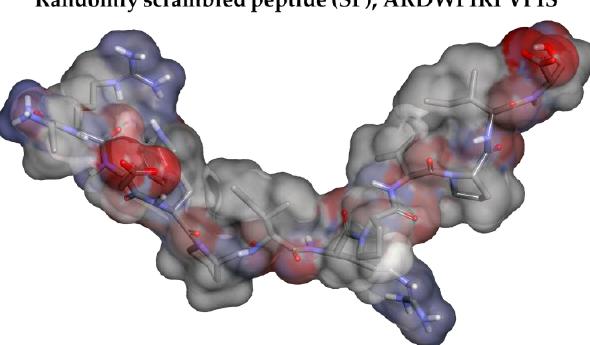
Figure 1. ( A ) Fluorescence microscopy imaging of FITC-positive cells. Primary HACs and PHSFs were incubated with synthetic FITC-CAP or PBS (control). ( B ) Flow cytometric analysis of FITC-positive cells was performed. HACs and PHSFs were incubated with varying concentrations of FITC-CAP (1 – 8 μ M). ( C ) Treatment of HACs and PHSFs with 8 μ M of scrambled FITC-SP. The cells were trypsinized and analyzed by flow cytometry. ( D ) Confocal fluorescence microscopic analysis of HACs. Cell was incubated with 8 μ M of FITC-CAP or FITC-SP and analyzed by a confocal microscope. ( E ) The mean intensity value of the confocal microscope data is shown . Results are presented as mean ± SEM. ** represents p < 0.01, and *** represents p < 0.001, n = 3. ( F ) Computer generating conformation of CAP and SP. The colors represent the evolution of the donor-acceptor charge property of amino acid sequences as illustrated in blue-to-red color for donor and acceptor units.